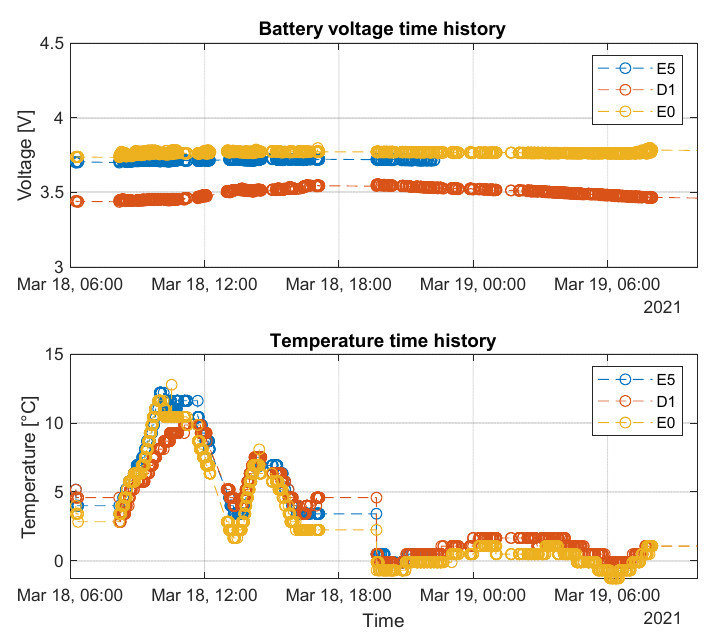
Figure 15. Example of battery voltage and temperature data.